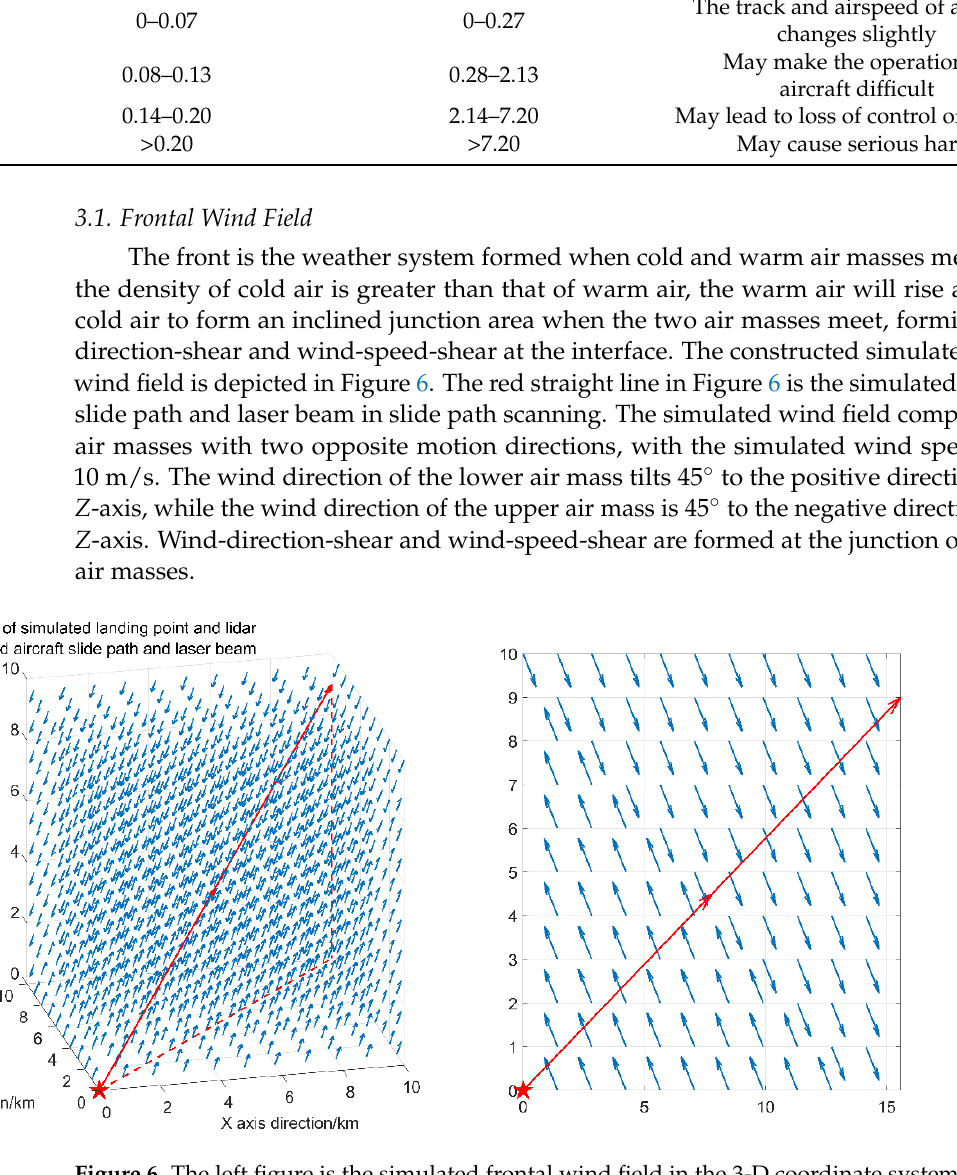
Figure 6. The left figure is the simulated frontal wind field in the 3-D coordinate system; the right figure is the profile view of the simulated frontal wind field.